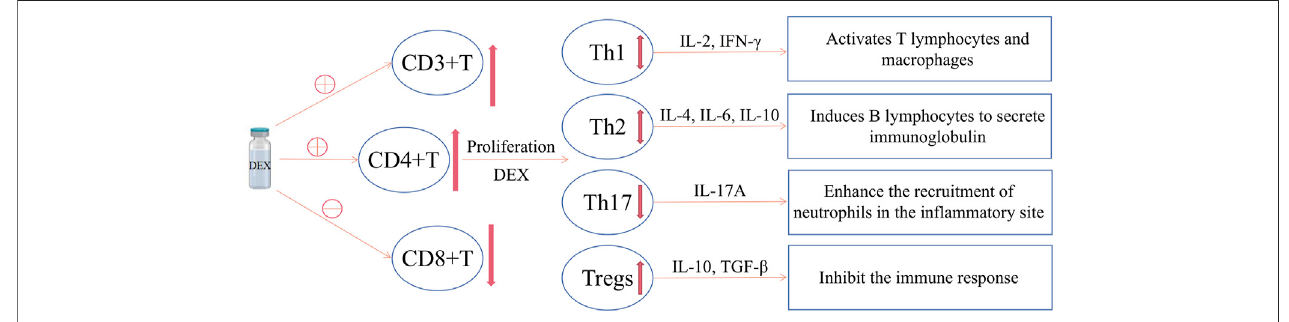
FIGURE1| TheeffectofDEXonTcells.DEXcanincreaseCD4 + Tcells,decreaseCD8 + Tcells,andincreasetheCD4+/CD8+value;meanwhile,DEXcanpromote the differentiation of CD4 + T cells into Tregs, reduce Th17 and the Th17/Tregs value; however, there is currently no consensus on the effect of DEX on Th1 and Th2.